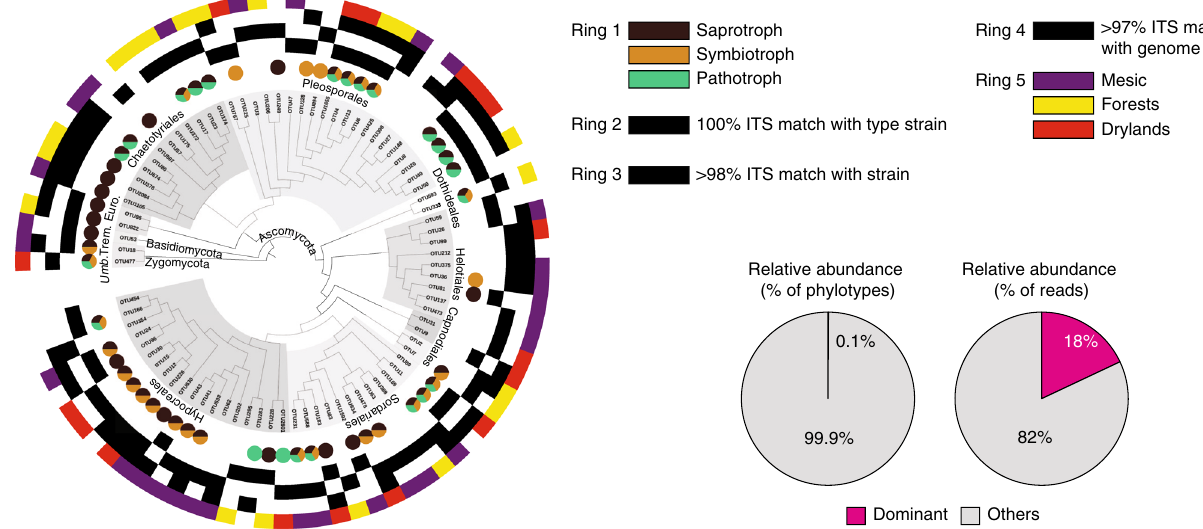
Fig. 1 Phylogenetic distribution of the 83 dominant fungal phylotypes. Ring 1 indicates the most likely functional guild for each phylotype, inferred by parsing the phylotypes with FUNguild 78 , where brown = saprotroph, yellow = symbiotroph, green = pathotroph. For each phylotype, black squares in Ring 2 and 3 indicate whether there is a representative type strain or isolate match at ≥ 98% ITS2 gene sequence similarity level, while black squares in Ring 4 highlights the presence of a matching genome at ≥ 97% similarity threshold. The colouring on the outermost ring matches the preferential environmental distribution for all phylotypes ( n = 83), where purple = mesic, yellow = forest, red = drylands. Trem. = Tremellomycetes, Umb. = Umbelopsis , Euro. = Eurotiomycetes. The abundance (%) and richness of the dominant phylotypes in relationship to the non-dominant phylotypes are reported in the pie charts. The nucloetide sequence of the dominant phylotypes is reported in Supplementary Data